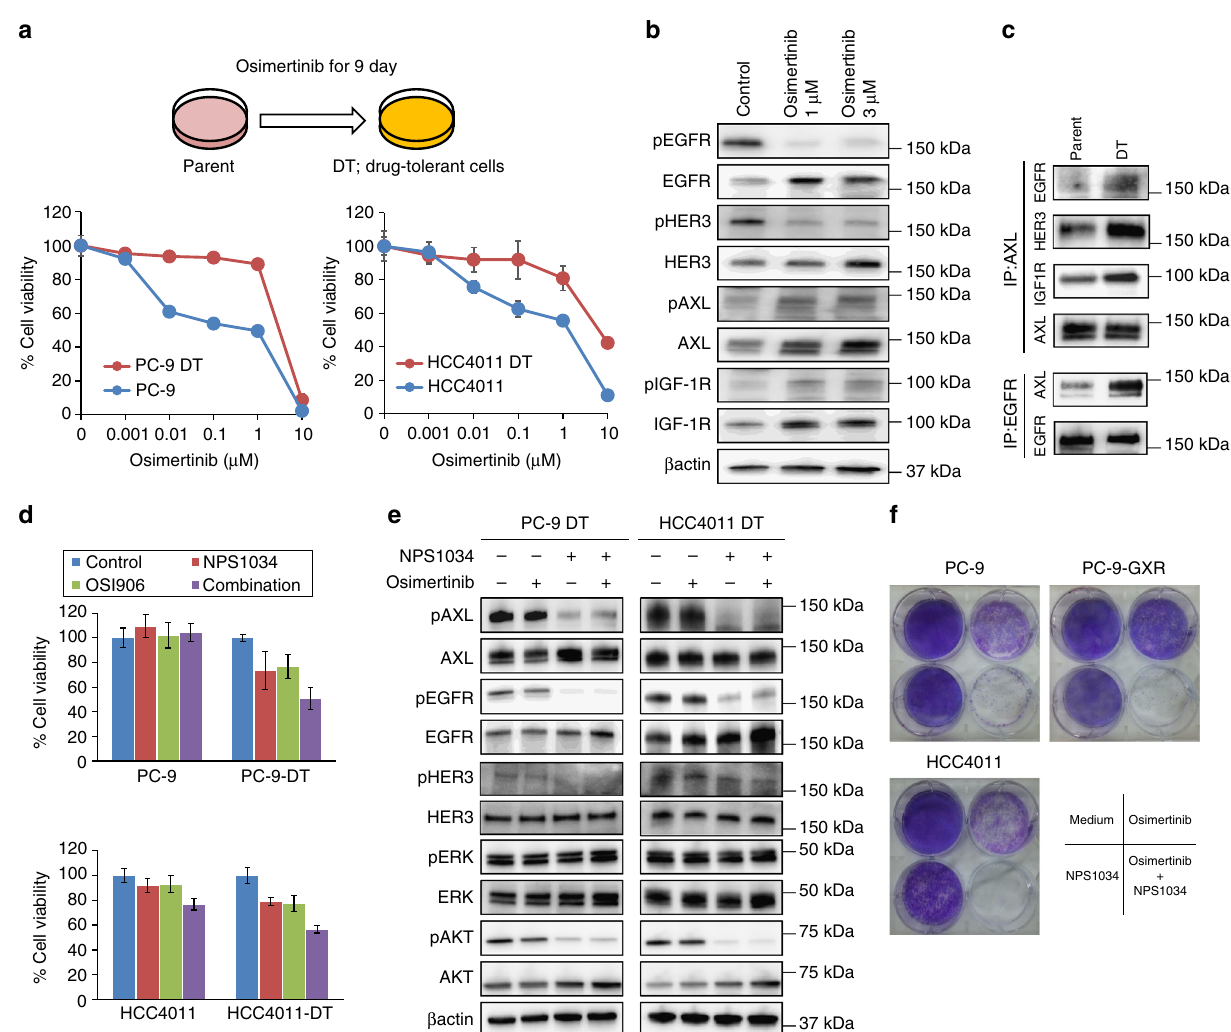
Fig. 5 AXL inhibitor prevented the emergence of drug-tolerant cells to osimertinib. a Drug-tolerant (DT) cells previously treated with 3 μ mol/L osimertinib for 9 days were treated with the indicated concentrations of osimertinib for 72 h and their viability was assessed using MTT assays. b PC-9 parental cells and DT cells generated by treatment with 1 or 3 μ mol/L osimertinib were lysed and the indicated proteins were detected by western blotting. c PC-9 parental cells and DT cells generated by treatment with 3 μ mol/L osimertinib for 9 days were lysed and the indicated proteins were detected by western blotting with immunoprecipitation of the indicated proteins. d PC-9, HCC4011 parental cells, and DT cells generated by treatment with 3 μ mol/L osimertinib were treated with 1 μ mol/L of NPS1034, OSI906, or a combination of these agents for 72 h and the cell viability was assessed using MTT assays. e The indicated cells were incubated with osimertinib (3 μ mol/L) with or without NPS1034 (1 μ mol/L) for 1 h. The cells were lysed and the indicated proteins were detected by western blotting. f Cells were treated with DMSO, 100 nmol/L osimertinib, 1 μ mol/L NPS1034, or a combination of 100 nmol/L osimertinib and 1 μ mol/L NPS1034 for 3 weeks with the drugs replenished every 72 h. The plates were stained with crystal violet and visually examined. A plate representative of three independent experiments is combined with osimertinib treatment in a cell-line-derived treatment with osimertinib and NSP1034 commenced during the xenograft (CDX) model using high-AXL-expressing PC-9 cells. initial phase prevented the rapid growth of high-AXL-expressing Using this approach, we evaluated the effect of NSP1034 using EGFR -mutated NSCLC cells in vivo. No apparent adverse events, two different treatment schedules, (1) during the initial phase and including weight loss, were observed during these treatments (2) during the tolerant phase. For the initial phase studies, mice (Supplementary Figure 16B). For the tolerant phase studies, all were continuously administered osimertinib alone, NSP1034 the PC-9 tumor-bearing mice were initially treated with osi- alone, or a combination of osimertinib and NSP1034 for 5 days a mertinib alone and the tumor size regressed within 1 week week by oral gavage until the end of experiment (Fig. 7a). (Fig. 7b). On day 8, the mice were randomly divided into two Treatment with NSP1034 alone had no effect on the growth of groups. One group was treated with osimertinib alone and the PC-9 tumors. Treatment with osimertinib alone caused tumor other was treated with both osimertinib and NSP1034. The regression within 1 week, but the tumors re-grew within 7 weeks, tumors treated with osimertinib alone re-grew, again showing indicating rapid recurrence due to acquired resistance. Combined rapid recurrence. The re-growth of the tumors treated with osi- treatment with osimertinib and NSP1034 also caused tumor mertinib and NSP1034 was much slower than those treated with regression within 1 week and the size of the regressed tumors was osimertinib alone. Overall, the results from the rapid recurrence maintained for 10 weeks. These results indicated that combined model using PC-9 cells indicated that the combined treatment of